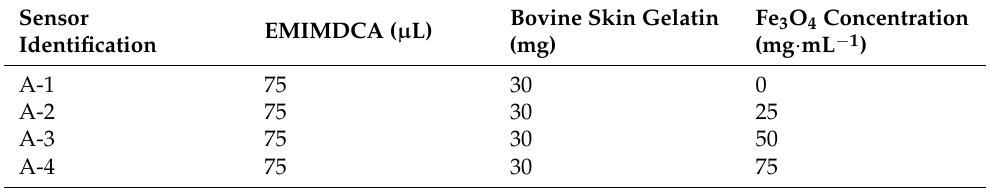
Table 1. Sensor identification and synthesis description according to components and their amounts.